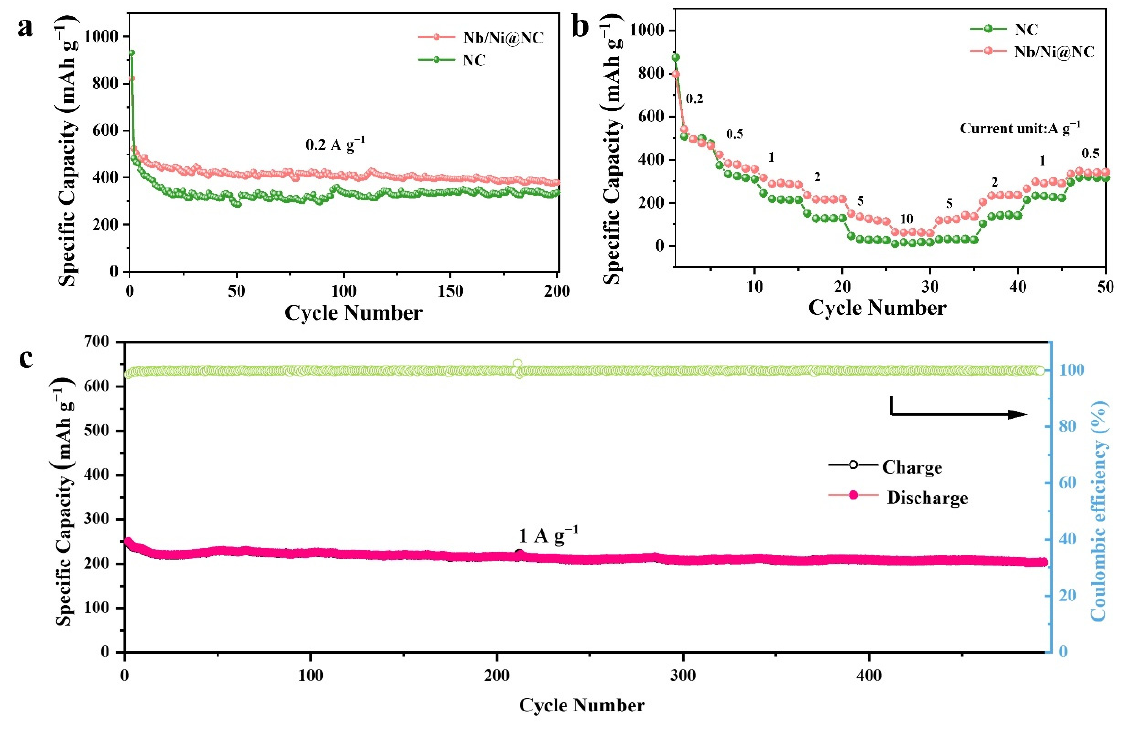
Figure 6. ( a ) Cycling performance of the flexible Nb/Ni@NC and NC electrodes at 0.2 A g − 1 ; ( b ) rate capability of the flexible Nb/Ni@NC and NC electrodes; ( c ) cycling performance of the flexible Nb/Ni@NC electrode at 1.0 A g − 1